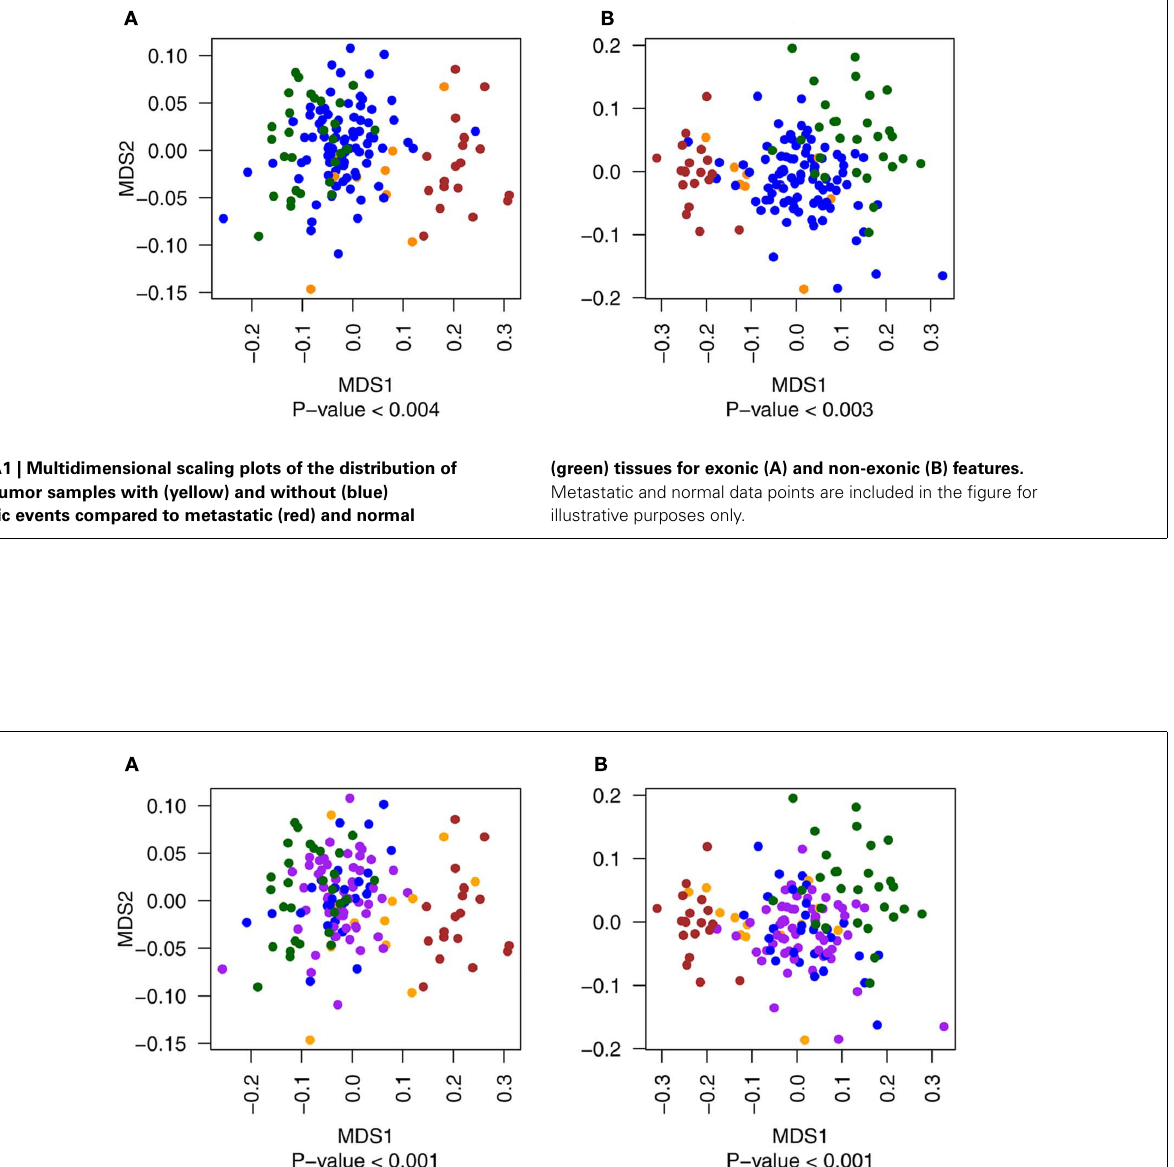
FIGUREA2 | Multidimensional scaling plots of the distribution of primary tumor samples with Gleason score of 6 (blue), 7 (purple), 8 and 9 (both in yellow) compared to metastatic (red) and normal